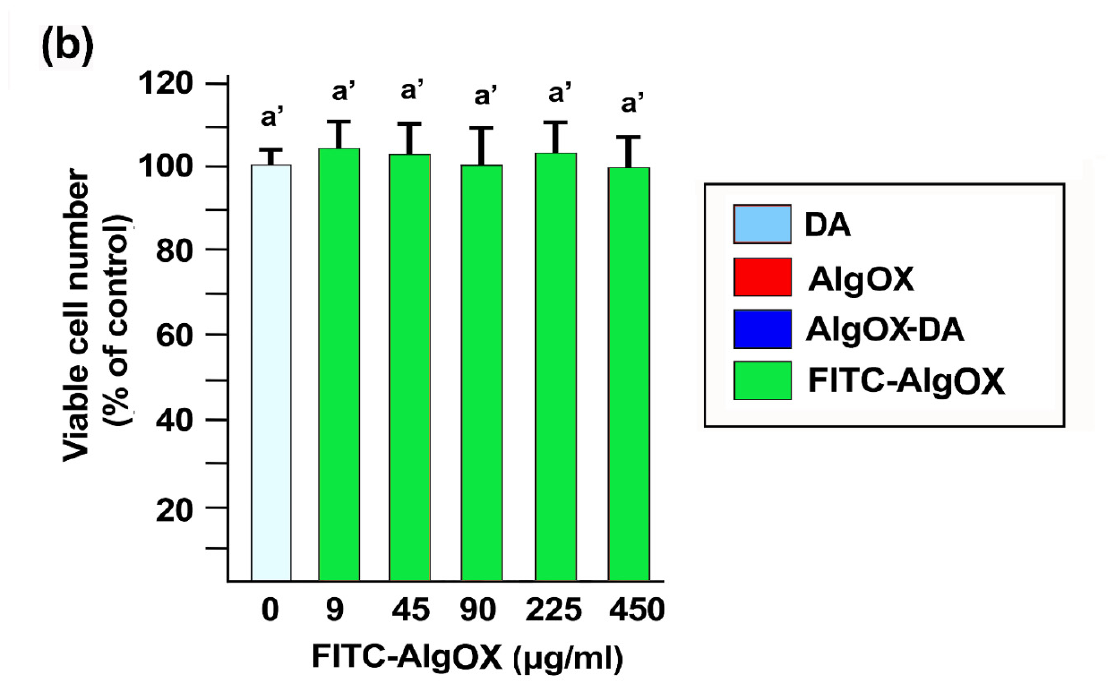
Figure 13. Sensitivity of SH-SY5Y cells to AlgOX and FITC-AlgOX. Cells were treated by varying concentrations of DA, AlgOX, AlgOX-DA ( a ) or FITC-AlgOX ( b ) and viable cell numbers were determined 24 h later with sulforhodamine B (SRB) assay. The data are means ± S.D. of four different experiments run in eight replicates and are presented as percent of control. Values of the histograms with shared letters are not significantly different according to Bonferroni/Dunn’s post hoc